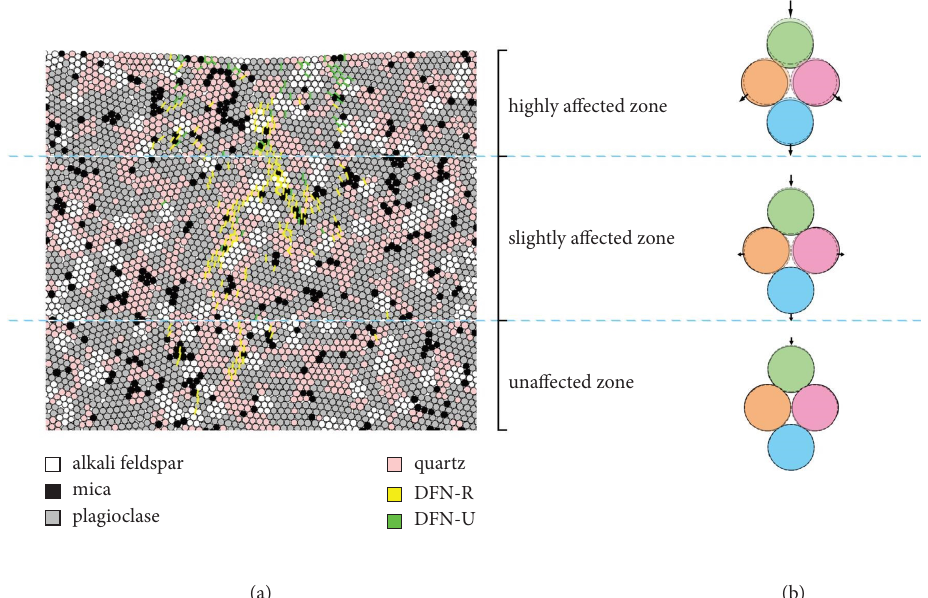
Figure 14: Infuence depth of ultrasonic vibration: (a) cracks generated by two loading modes and (b) position change in rock particles under ultrasonic vibration. Yellow lines represent cracks caused by rolling load, and green lines represent ultrasonic